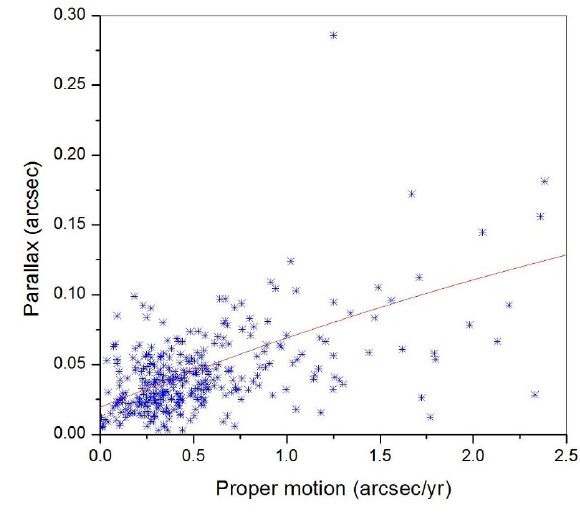
Figure 2. Distribution of parallaxes vs. proper motions for